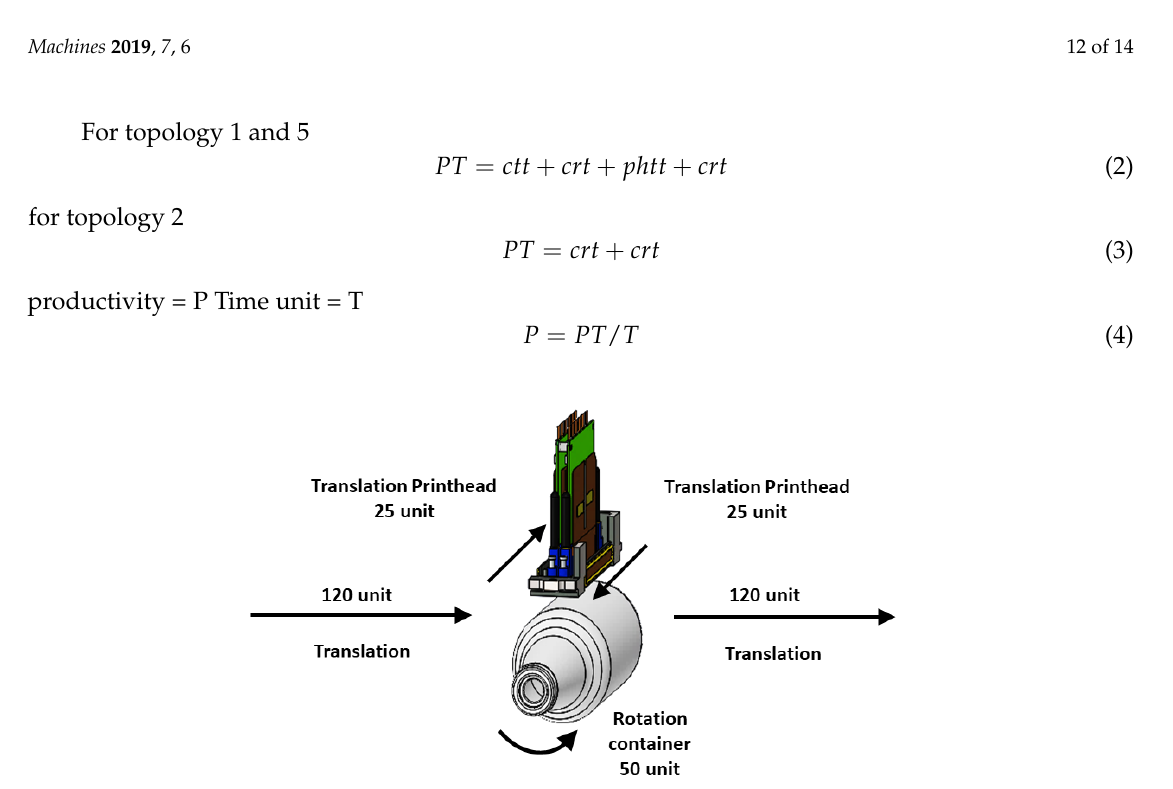
Figure 11. General print time